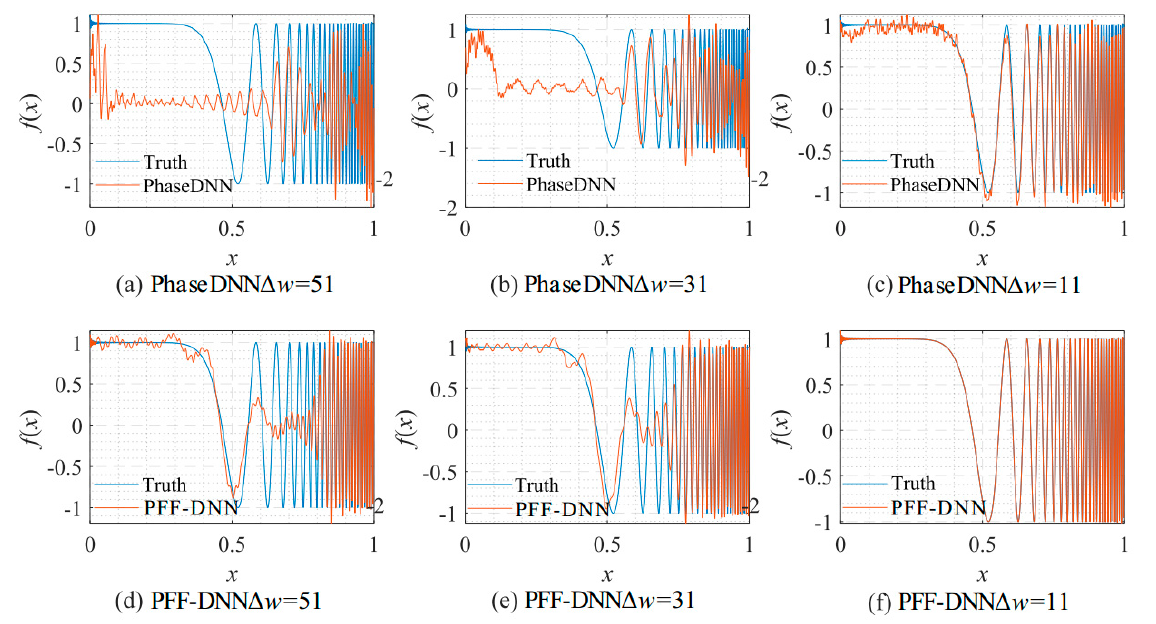
Figure 16. The influence of Δ ω on the algorithm performance. The fitting results of the PhaseDNN method after 10,000 updates: ( a ) Δ ω = 51; ( b ) Δ ω = 31; and ( c ) Δ ω = 11. The fitting results of the PFF-DNN method after 10,000 updates: ( d ) ∆ ω = 51; ( e ) ∆ ω = 31; and ( f ) ∆ ω = 11.